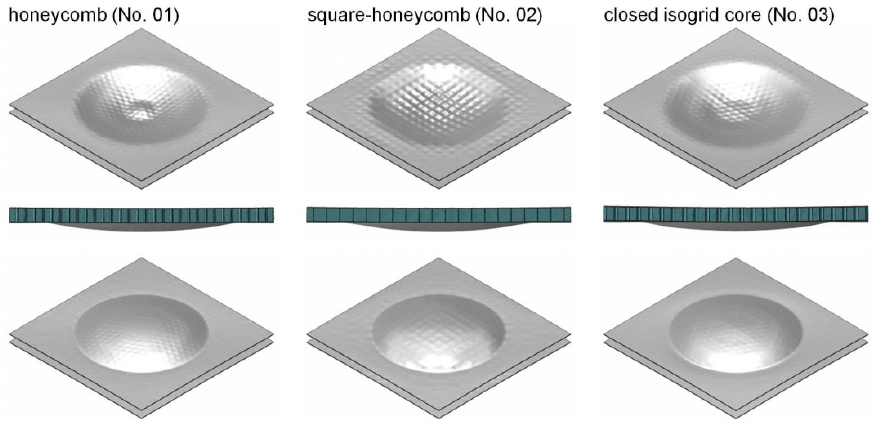
Figure A1. Deformation states of the top and bottom sides for honeycomb cores No. 01–03 subjected to air-blast loading (t = 0.6 ms).